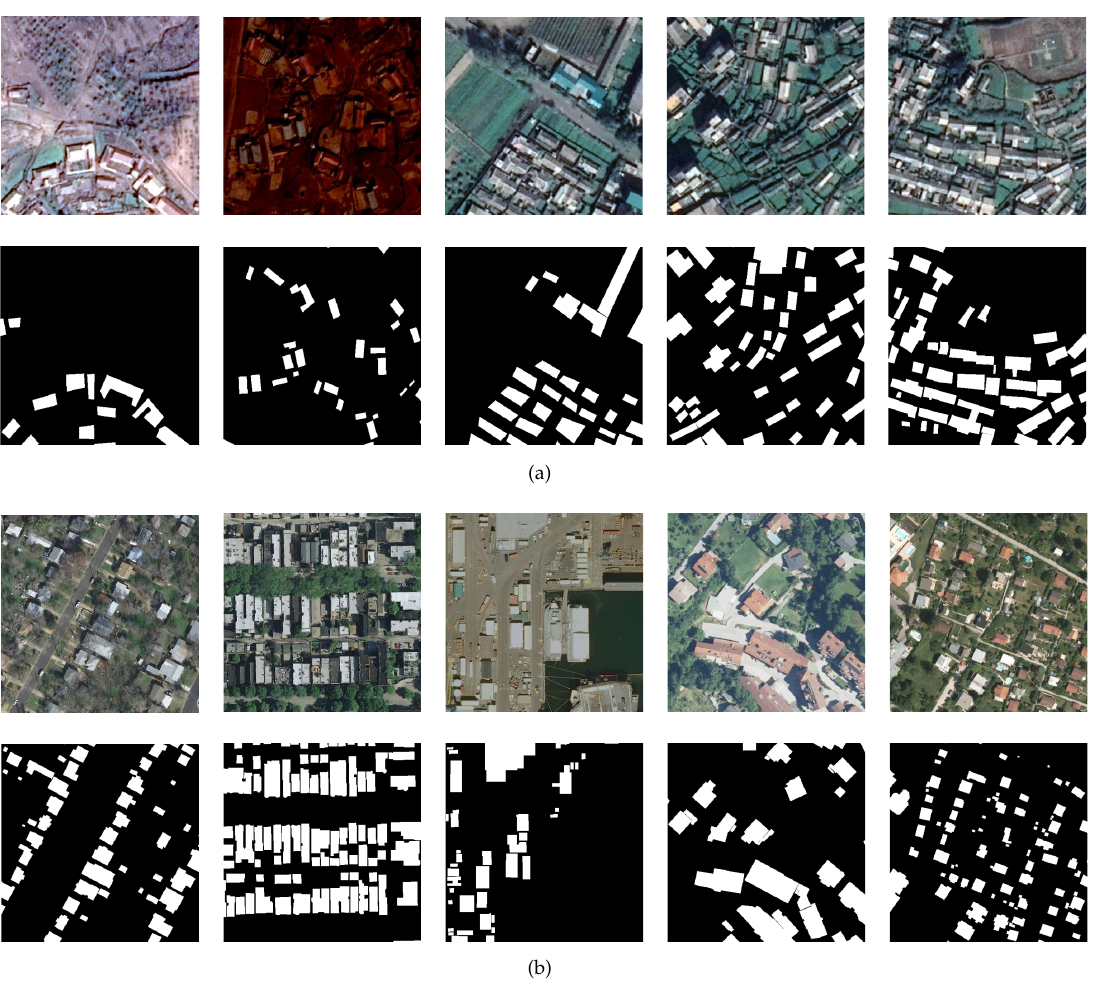
Figure 4. Some examples of two benchmark datasets. ( a ) East Asia Dataset. ( b ) Inria Aerial Image Dataset. The first row in each subplot is the aerial image tile, and the second row is the ground